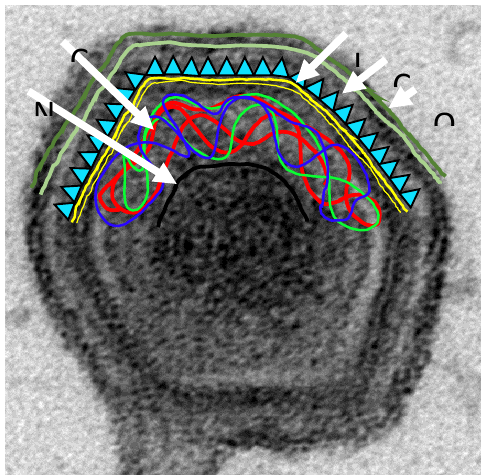
Figure 1. African swine fever virus (ASFV) structure. An electro micrograph of an extracellular ASFV particle budding through the cell plasma membrane is shown. The particle is large (~200 nm) and complex containing more than 50 proteins. Several layers are indicated on the cartoon. The nucleoprotein core (NU) is surrounded by the core shell (CS) and the inner envelope (IE) on which the icosahedral capsid (CA) is assembled. This intracellular mature particle is assembled in cytoplasmic virus factories. The extracellular virus particles gain an additional outer envelope (OE) budding through the cells plasma membrane. The OE contains ASFV proteins, CD2v/EP402Rp, p12/O61Rp and the cellular protein designated p24; the CA contains major protein p72/B646Lp and also E120Rp, B438Lp; the IE contains p17/D117Lp, p54/E183Lp, E248Rp and p12/O61Rp; CS contains the cleavage products of polyproteins pp220/CP2475Lp (p150, p37, p34, p14) and pp62/CP530Rp (p35, p15) and S273Rp; the NU contains p10/K78Rp, 104Lp, proteins and enzymes required to initiate infection including the virus RNA polymerase as well as the virus genome.